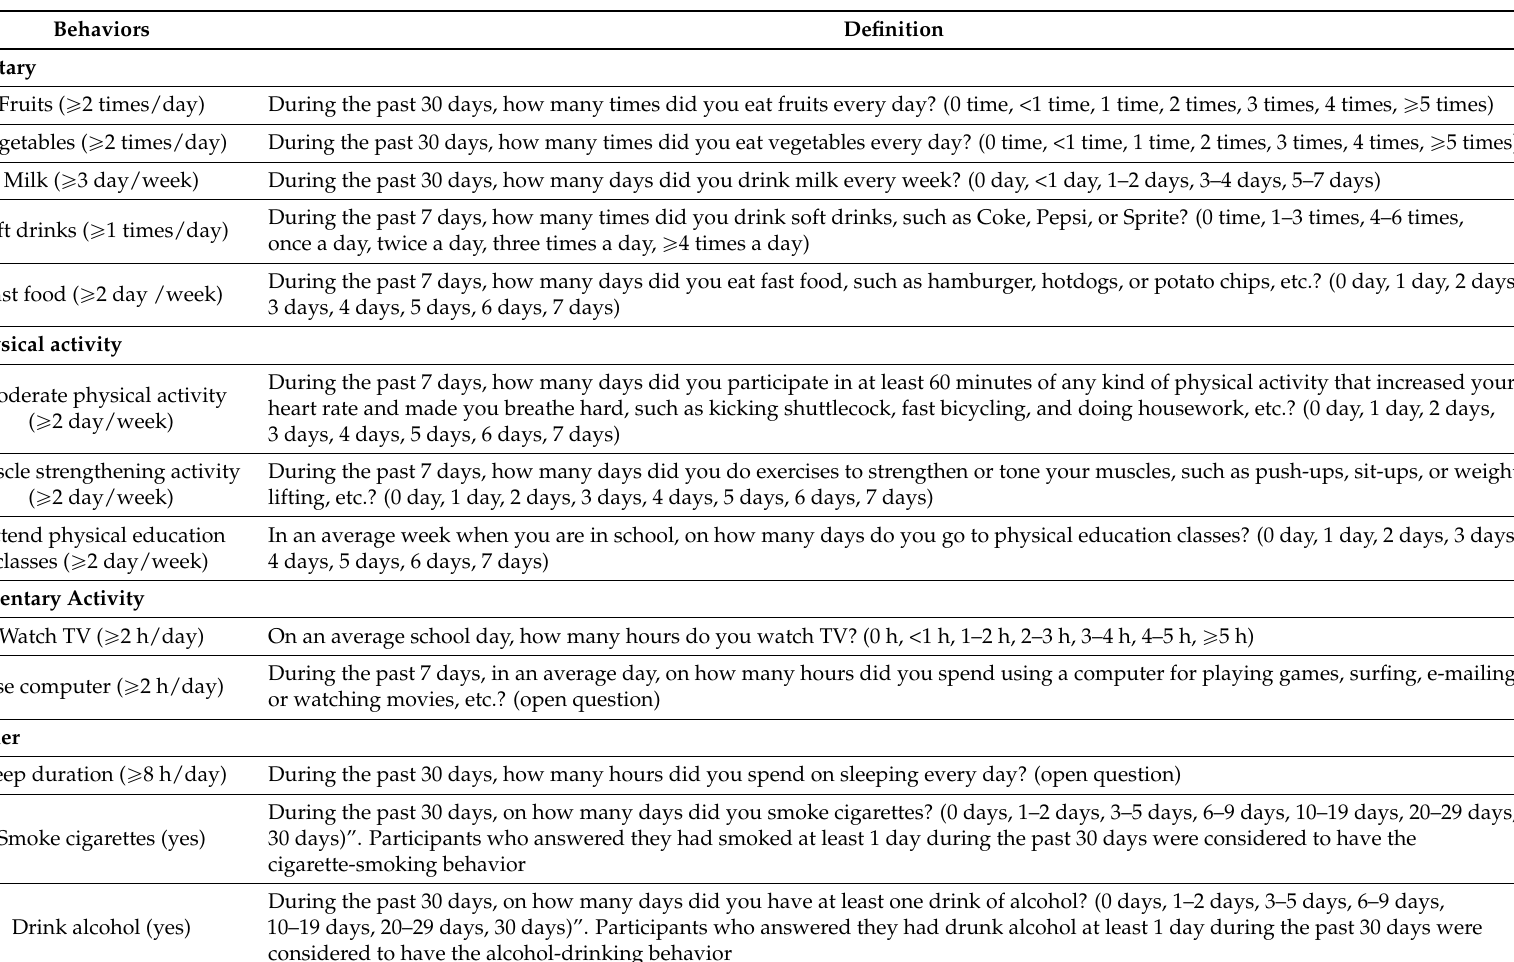
Table 1. The definition of dietary, physical activity, sedentary, and other